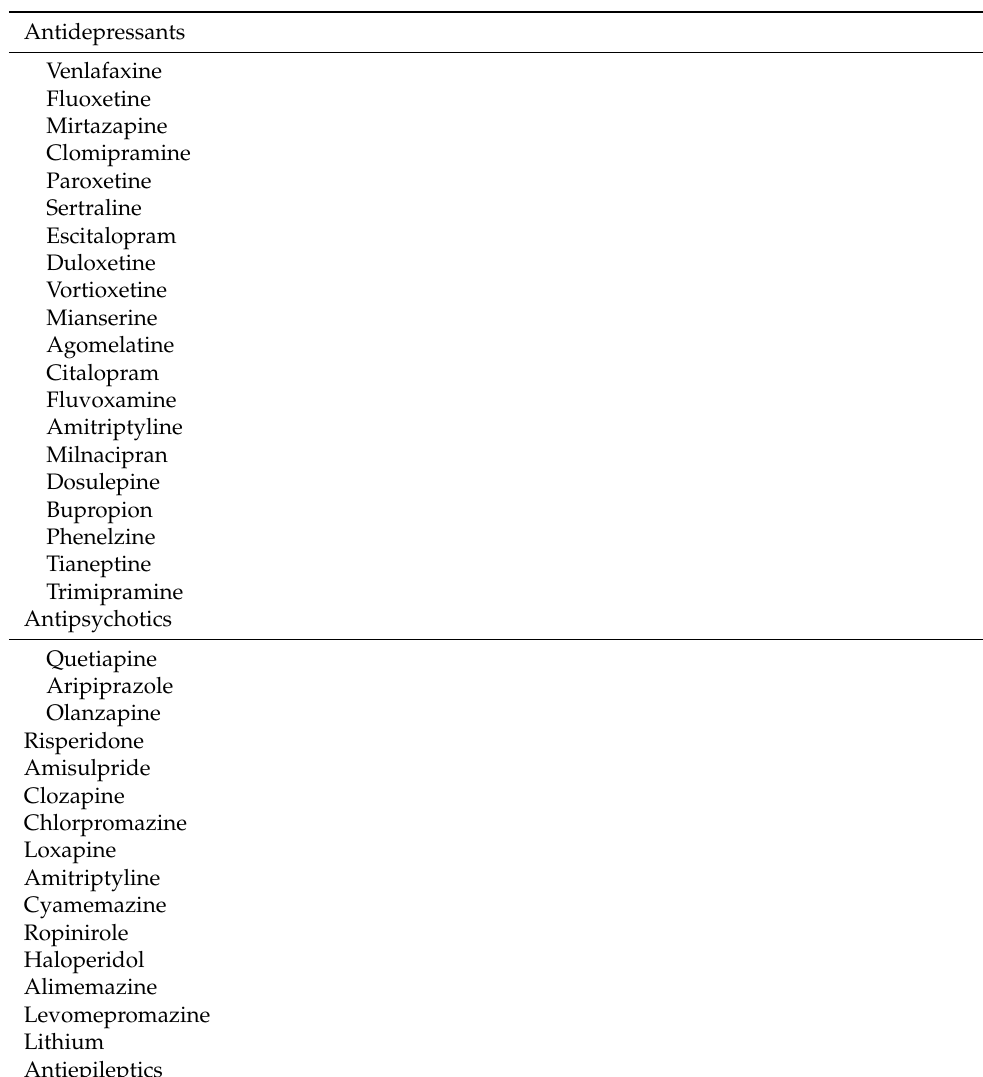
Table A1. List of drugs that might have led to a phenotypic